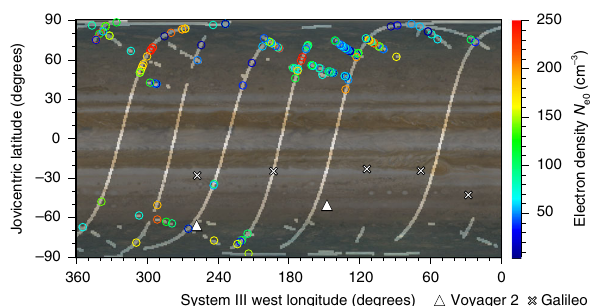
Fig. 4 Estimated electron density N e0 of the JDP locations using the propagation model. This pro fi le is the upper bound ionospheric density because the JDP L – O mode waves should transect Jupiter ’ s ionosphere and plasma irregularities from the lightning stroke to Juno. The transparent regions correspond to vertical projections of Juno when the Waves LFR-Hi observations were made. The observational locations of radio occultation measurements are depicted as triangles for Voyager 2 20 and crosses for Galileo 21 . The Jovian image was provided by